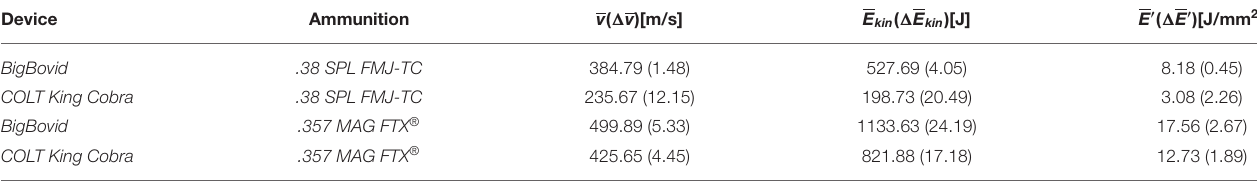
TABLE 1 | Ballistic data, given as mean value and mean error.